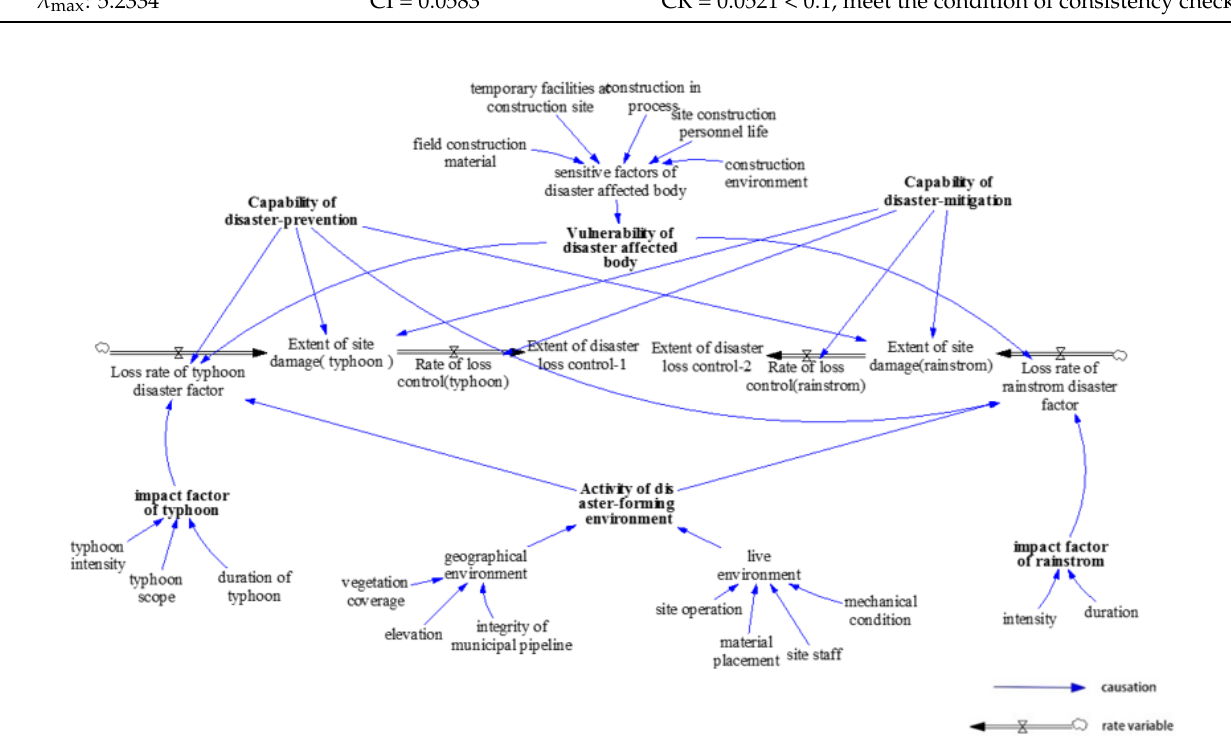
Figure 3. A flow diagram of a disaster system at a construction site under disasters.